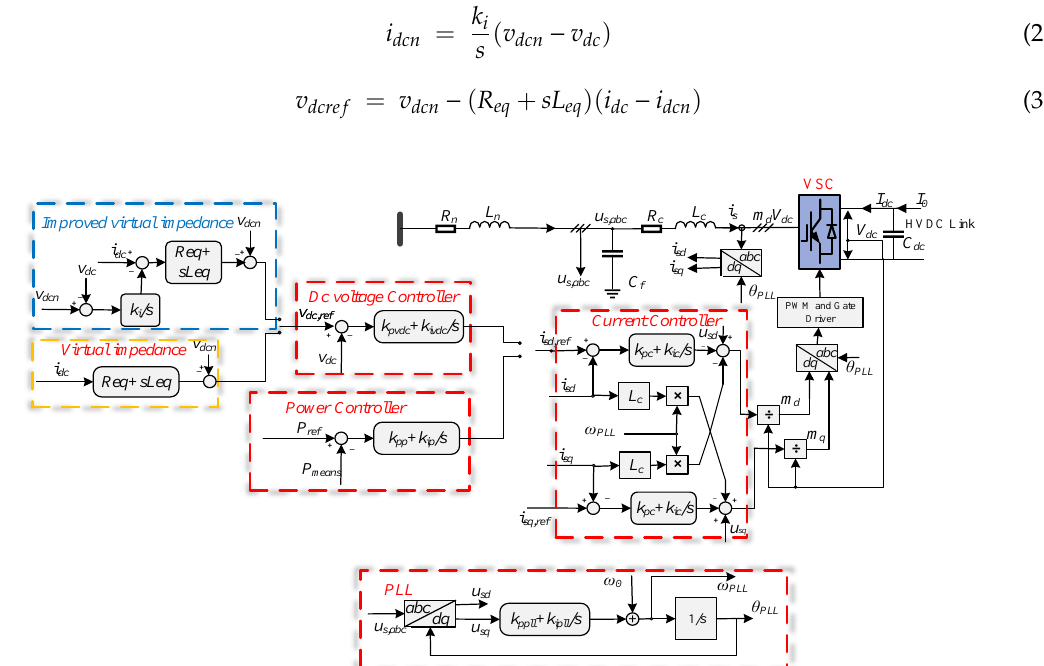
Figure 5. Proposed control structure of the converters.